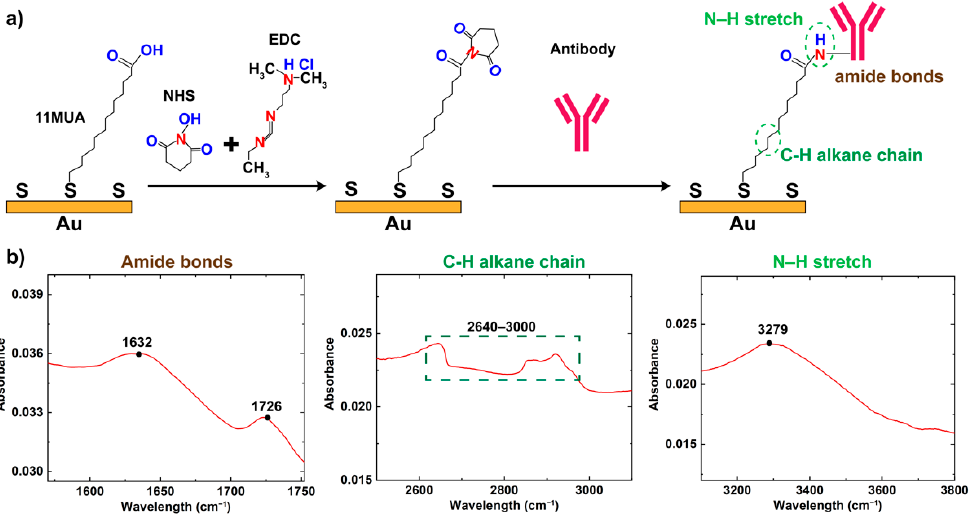
Figure 2. ( a ) Schematic illustrating the formation of SAM layer, EDC/NHS chemistry and antibody conjugation on the gold electrode surface. ( b ) FTIR spectrum for amide bonds, C-H alkane chain and N-H stretch.